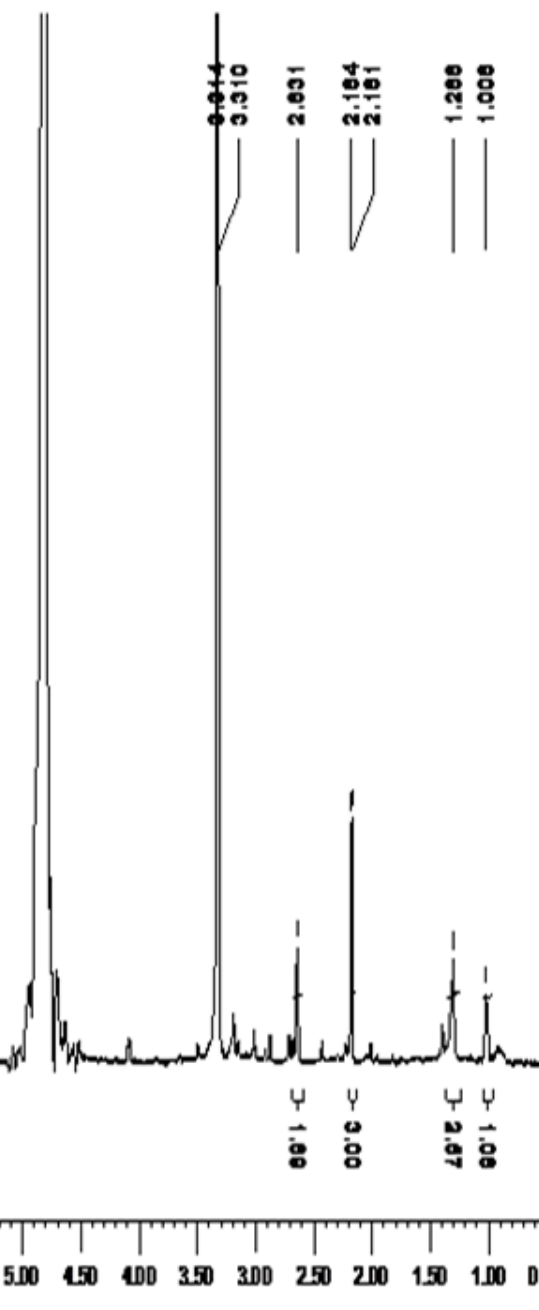
Figure 2. 1 H-NMR spectrum of [RuL